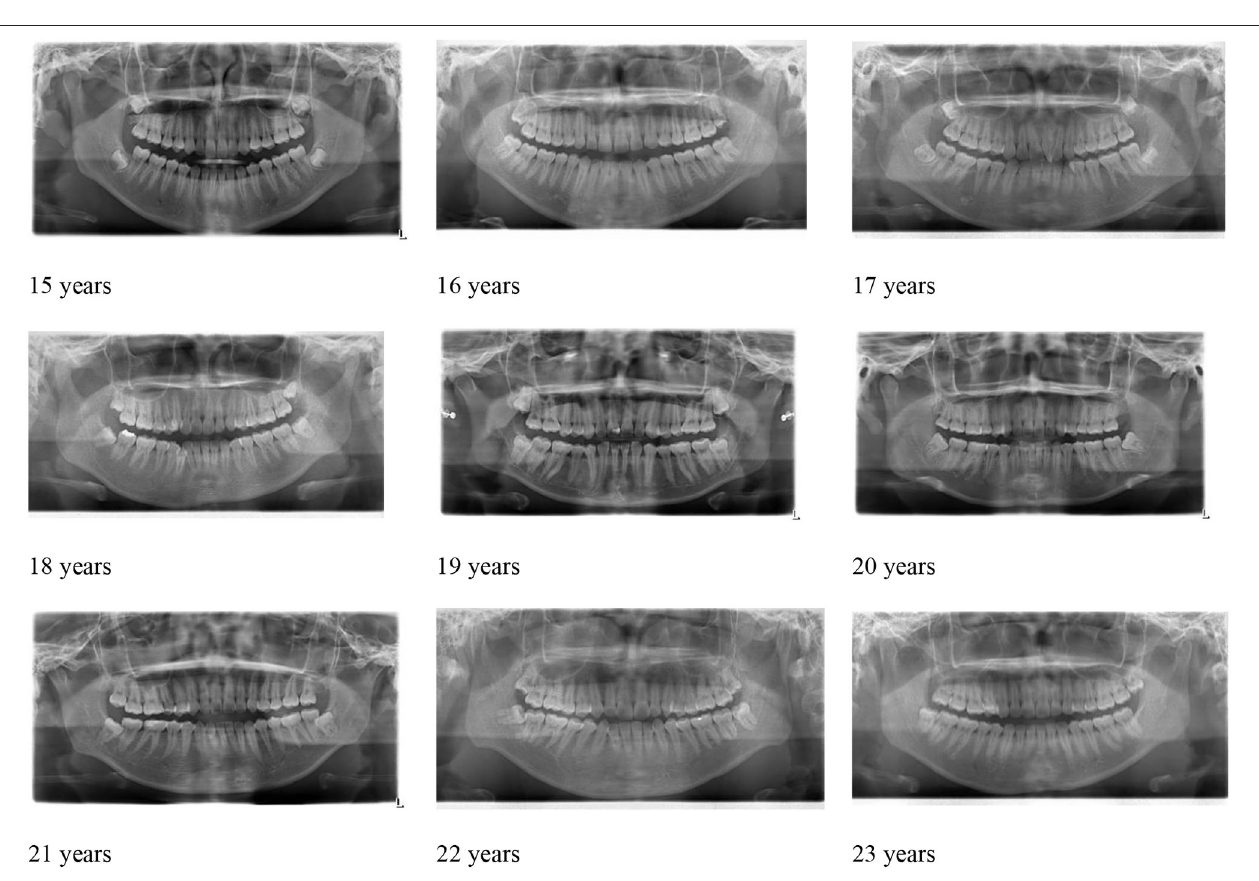
FIGURE 3 | Representation of each age